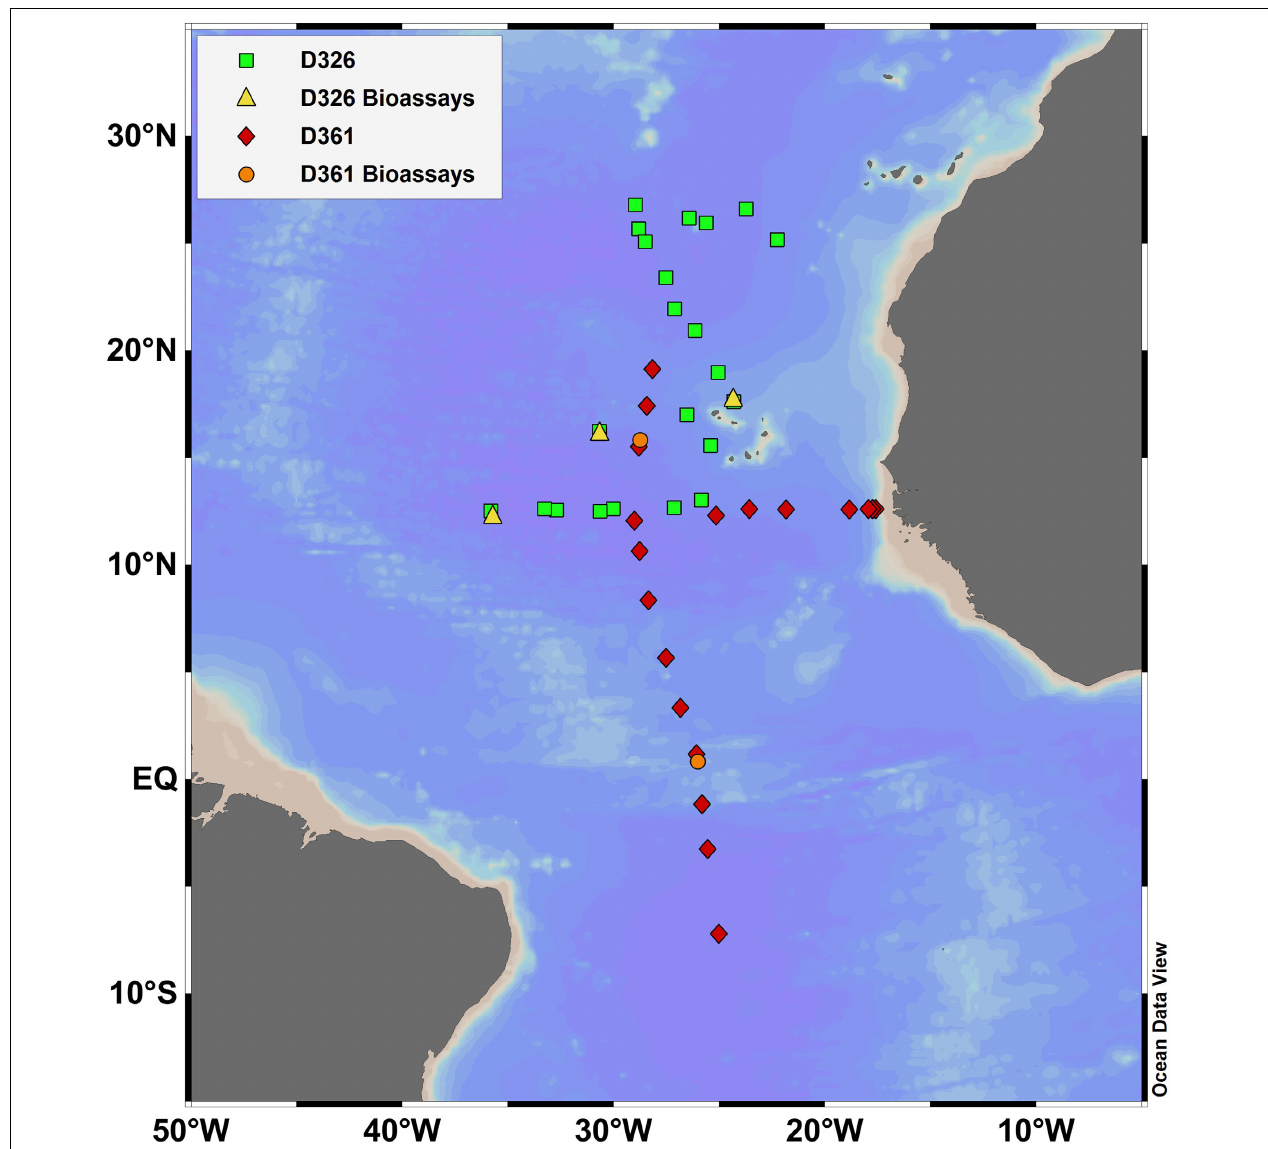
FIGURE 1 | Location of sampling stations for D326 (squares), D361 (diamonds), nutrient and dust addition experiments during D326 (triangles) and zinc addition experiments during D361 (circles) in the eastern tropical and subtropical Atlantic